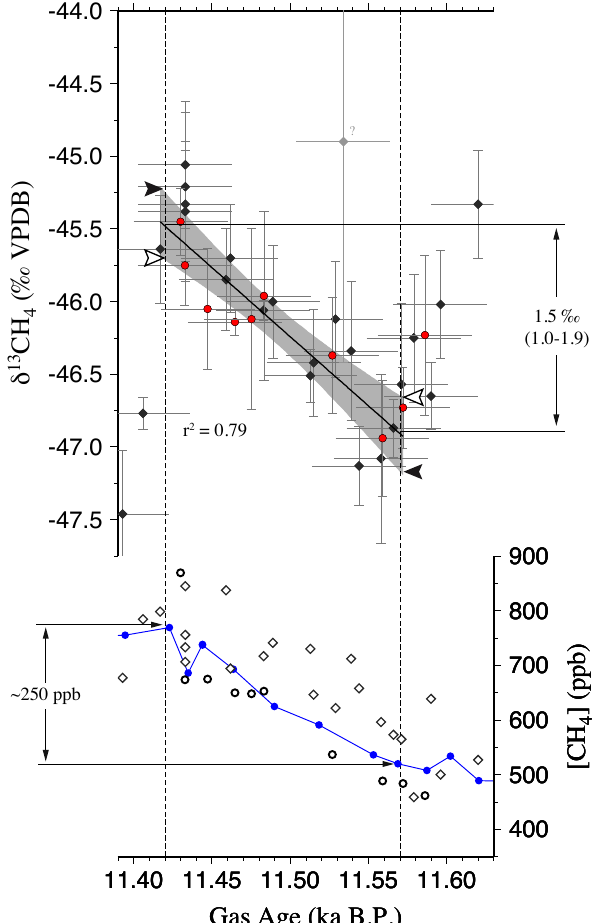
Fig. 4. The YD-PB equilibrated atmospheric δ 13 CH 4 and [CH 4 ] record from P˚akitsoq ice samples. The top panel shows the iso- topic disequilibrium corrected δ 13 CH 4 from this study [circles] and Schaefer et al. (2006) [diamonds]. The data are fit with a weighted linear regression between the gas ages of the last low [CH 4 ] value and the peak [CH 4 ] value in the GISP2 record (shaded region is the 99% model fit confidence interval). The δ 13 CH 4 value range is found from the model confidence interval’s minimum [unfilled arrowheads] and maximum [filled arrowheads] differences. The es- timated range in age per sample is ca. 25–35yr (indicated as un- capped horizontal bars), which includes both sample thickness and gas age distribution due to diffusion and bubble enclosure (Schae- fer et al., 2006). Bottom panel: [CH 4 ] records from GISP2 [blue line] (Brook et al., 2000) and P˚akitsoq (open circles [this study] and diamonds – Schaefer et al.,